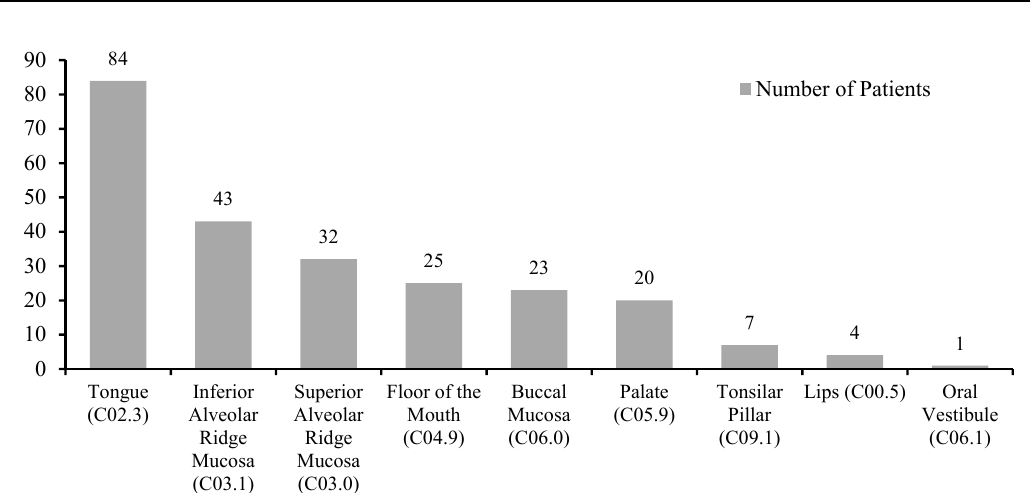
Figure 1. Distribution of cases according to the sites of Oral Squamous Cell Carcinoma (OSCC) defined by the 10th edition of the International Classification of Diseases (ICD-10) version 2010 in the Test Group (TG).